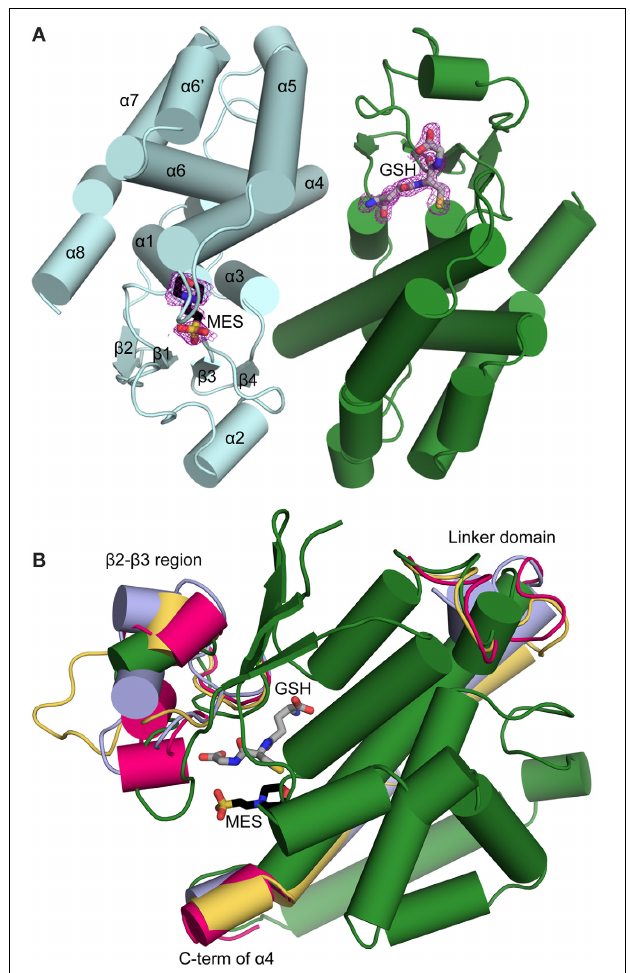
FIGURE 5 | Overall structure of PttGSTF1 and comparison with other plant GSTFs. (A) Architecture of PttGSTF1 dimer. The MES molecule (black) is located in the H site, as shown in monomer A whereas the GSH molecule (gray) bound to the G site is depicted in monomer B. Monomers A and B are colored in light cyan and dark green respectively. Secondary structures are labeled only for monomer A for clarity. The GSH and MES molecules are shown as sticks and colored according to atom type (nitrogen, blue; oxygen, red; sulfur, yellow; and carbon, gray/black). Omit map (colored in purple) of contour level of 0.8 σ is shown around each bound ligand. It was built using the Composite omit map command of the Phenix software suite. (B) Superimposition of monomers of PttGSTF1 (dark green), A. thaliana GSTF2 (pink) and Z. mays GST-I (blue) and GST-III (yellow). Only noticeable secondary structural differences between GSTFs are shown for clarity. The GSH (gray) and MES (black) molecules highlight the putative positions of the G and H sites respectively. GSH and MES molecules are colored according to atom type and shown as